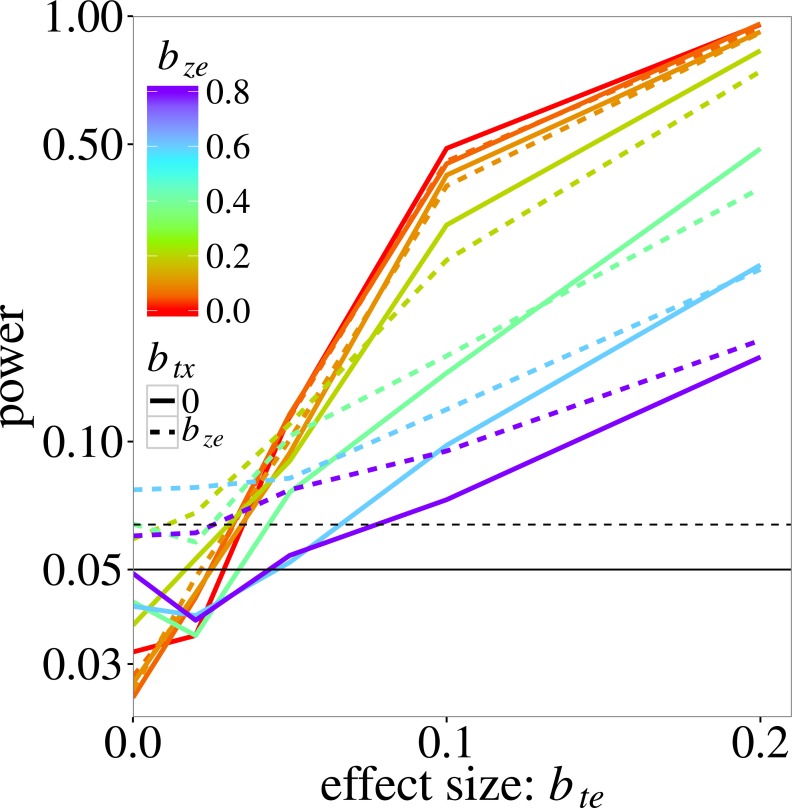
Power of the max r/c test (GLM based pmax test) on the trait-environment (t–e) interaction, added to the log-linear simulation model of Eq. (5), in relation the size of the interaction of interest with colours for various sizes of the z–e nuisance interaction (of e with a latent trait z) and linetypes as in Fig. 1.The vertical scale is logarithmic. The data were generated using a negative-binomial distribution with variance function \documentclass[12pt]{minimal}
\usepackage{amsmath}
\usepackage{wasysym}
\usepackage{amsfonts}
\usepackage{amssymb}
\usepackage{amsbsy}
\usepackage{upgreek}
\usepackage{mathrsfs}
\setlength{\oddsidemargin}{-69pt}
\begin{document}
}{}${\mu }_{ij}+{\mu }_{ij}^{2}$\end{document}μij+μij2, whereas the test statistic was based on the Poisson likelihood. The horizontal line at 0.05 indicates the nominal significance threshold; rates above the dotted line (at 0.064) are significantly greater than 0.05.